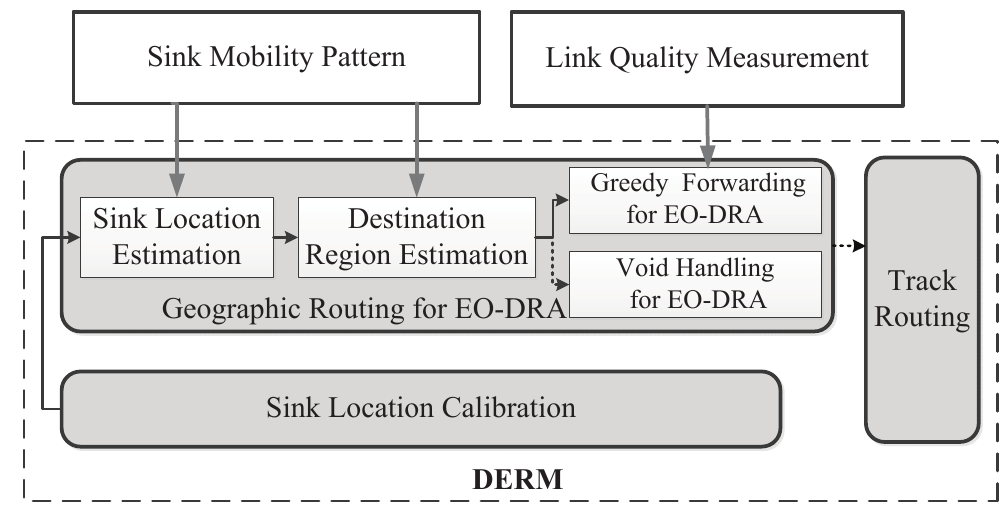
Figure 2. DERM framework